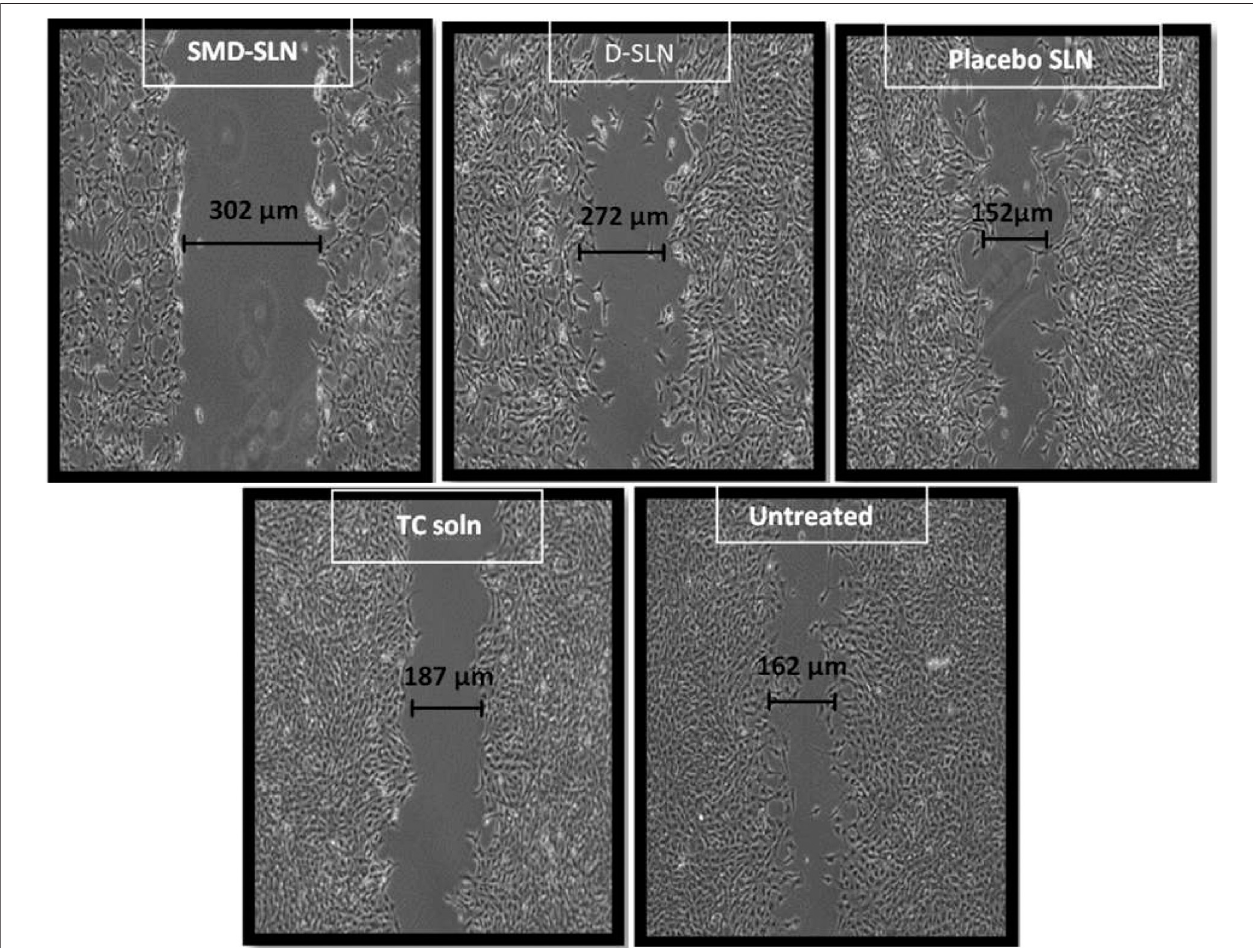
FIGURE 5 | Wound coverage results of developed SLN formulations in wound scratch